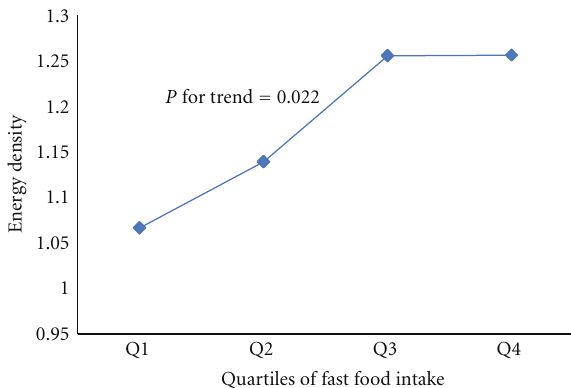
Figure 1: Dietary energy density across quartiles of fast food consumption.